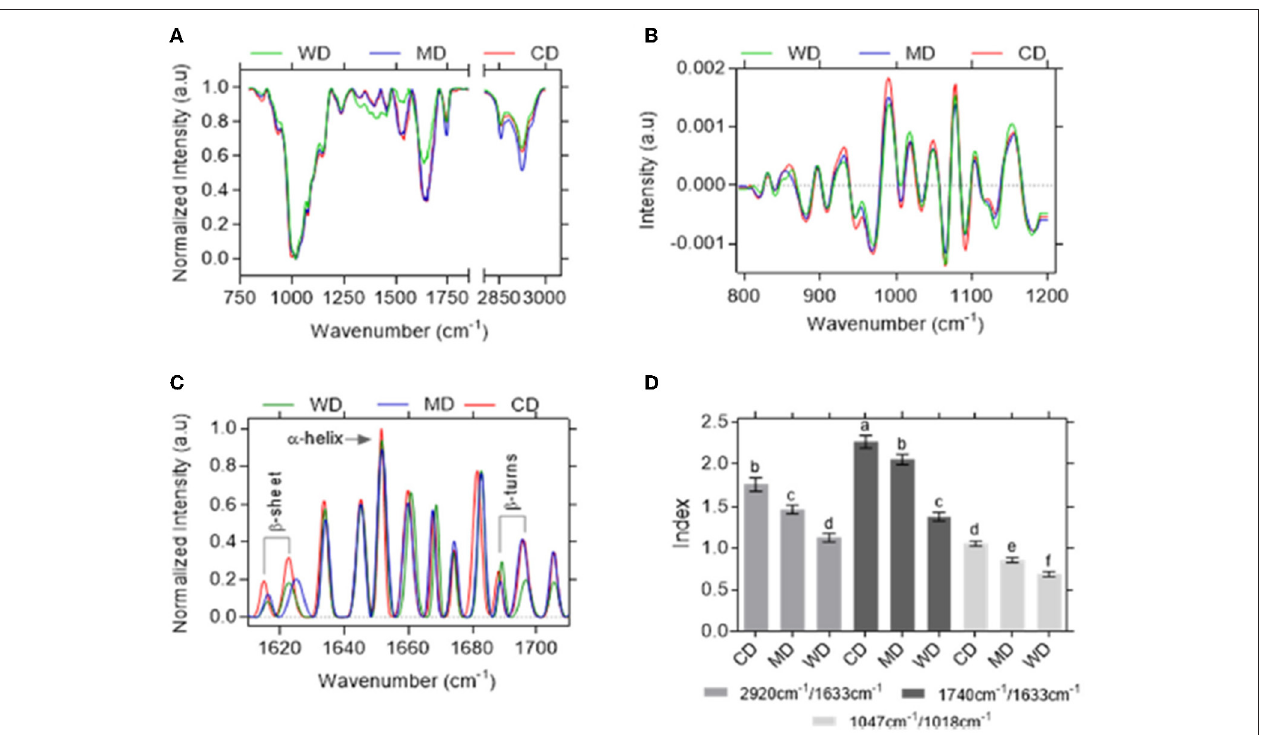
FIGURE 2 | Structural analysis spectra of defatted and without defatting hyperprotein flours. Protein-associated peaks (A) , deconvolution of peaks in the bands between 800–1,200cm − 1 (B) , deconvolution of peaks in the three types of flour in the bands between 1,600–1,800cm − 1 (C) , protein index for CD, MD and WD flour (D)